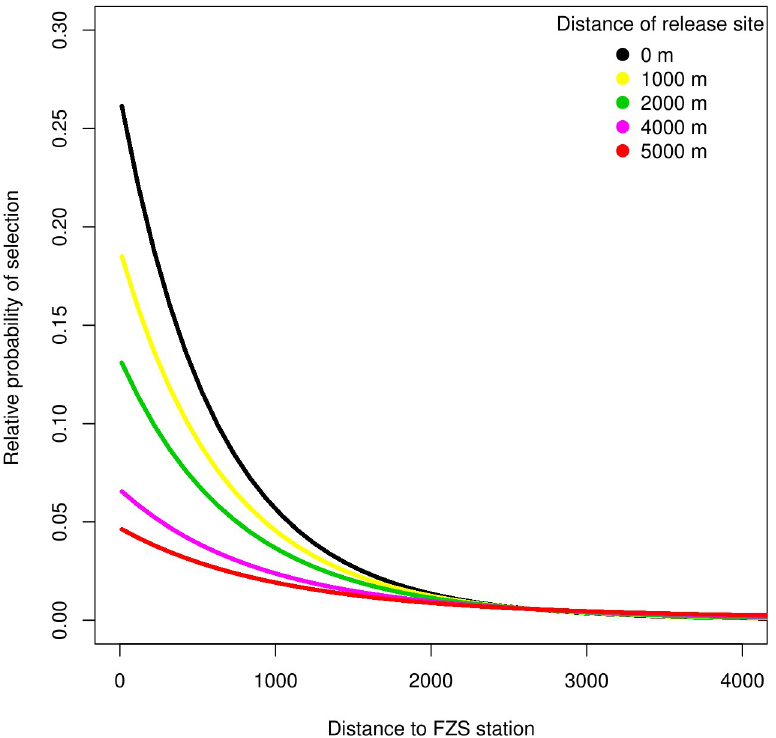
Fig 5. Individuals released further from the FZS station show less inclination to spend time in its vicinity. Relative probability of selection in 32 orangutans (n = 13 females, n = 19 males) as a function of the distance of the release site from the FZS station (five different scenarios, in meters) interacted with the distance to the FZS station (in meters). The lines represent the average relative probability of selection as predicted by the resource selection function.